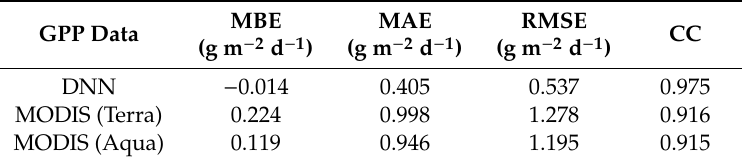
Table 5. Validation statistics of 8 day gross primary productivity (GPP) at the Gwangneung site from Moderate-resolution Imaging Spectroradiometer (MODIS) products and the deep neural network (DNN) predictions, against the eddy covariance (EC) measurements during 2006–2015. GPP